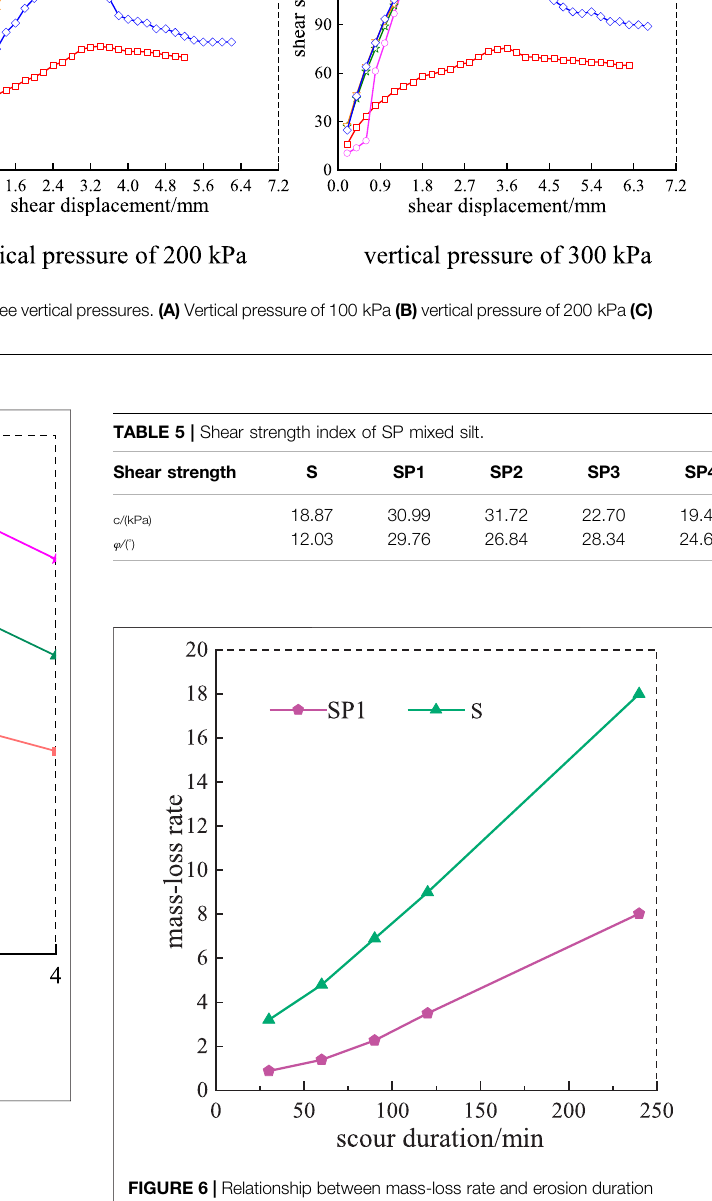
Frontiers in Earth Science |